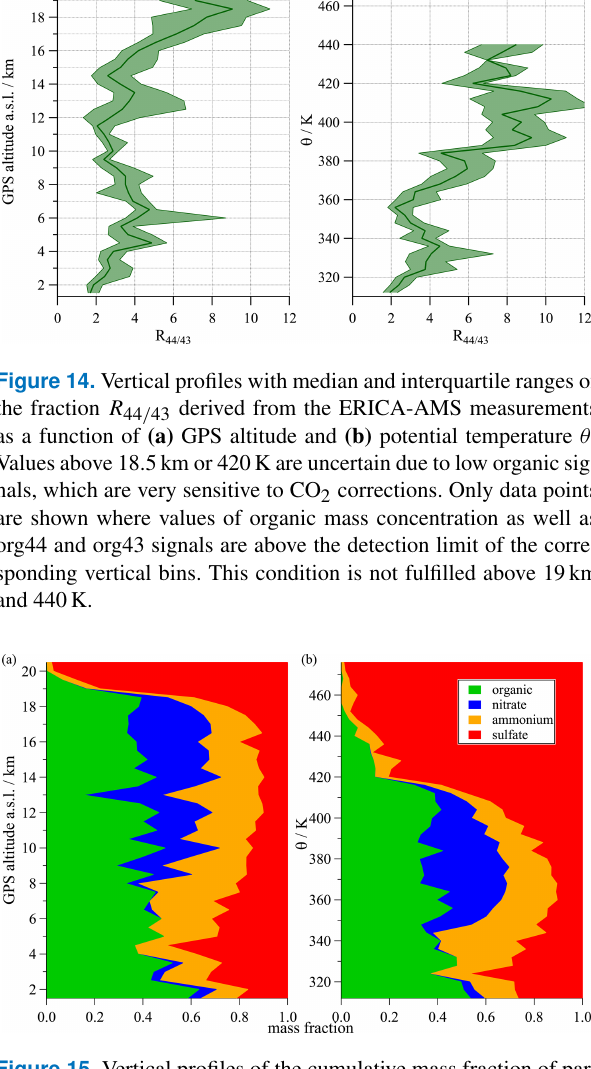
Figure 15. Vertical profiles of the cumulative mass fraction of par- ticulate organics (green), nitrate (blue), sulfate (red), and ammo- nium (yellow) from the ERICA-AMS as a function of (a) GPS alti- tude and (b) potential temperature θ